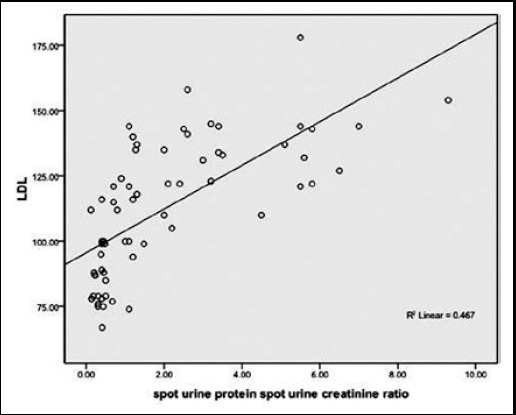
Correlation of LDL and Proteinuria.